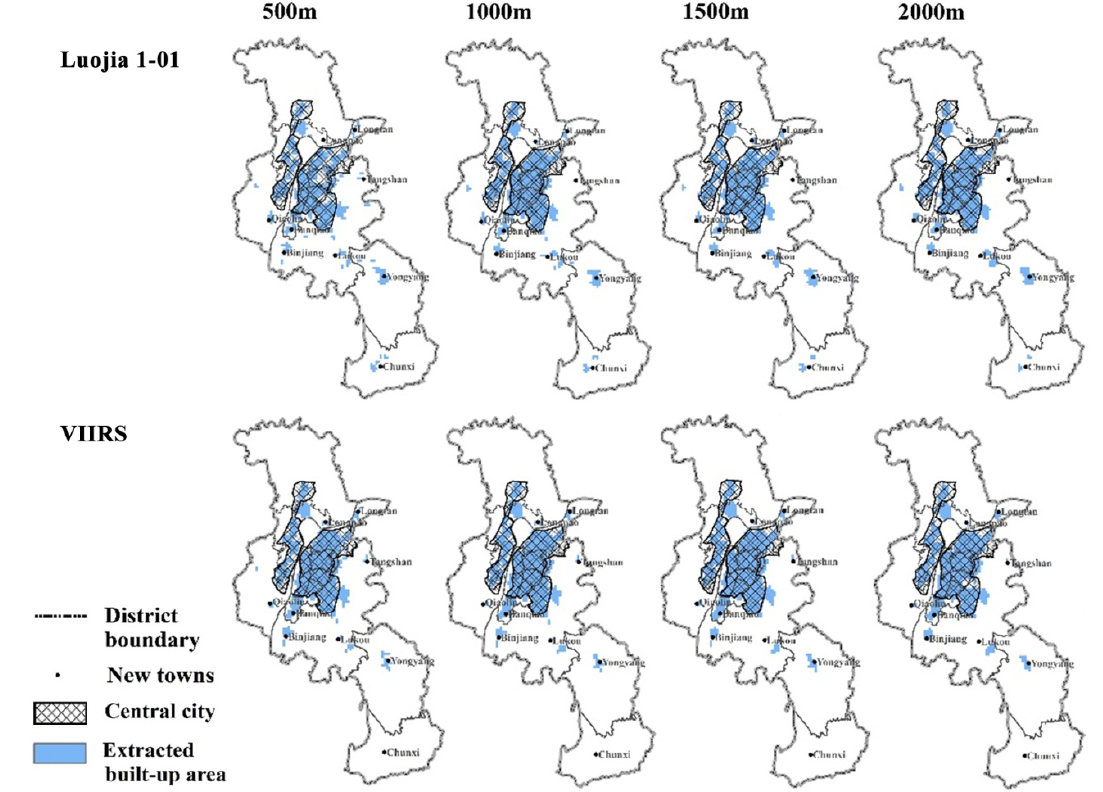
Figure 5. Comparison of extraction results and the urban structure of Nanjing, in which blue areas indicate extracted built-up areas, hatched areas indicate the central city, points represent new towns, and boundaries between districts are drawn. Kernel density estimation (KDE) was conducted respectively on VANUI_LUOJIA and VANUI_VIIRS under the search radius of 500 m, 1000 m, 1500 m, and 2000 m.